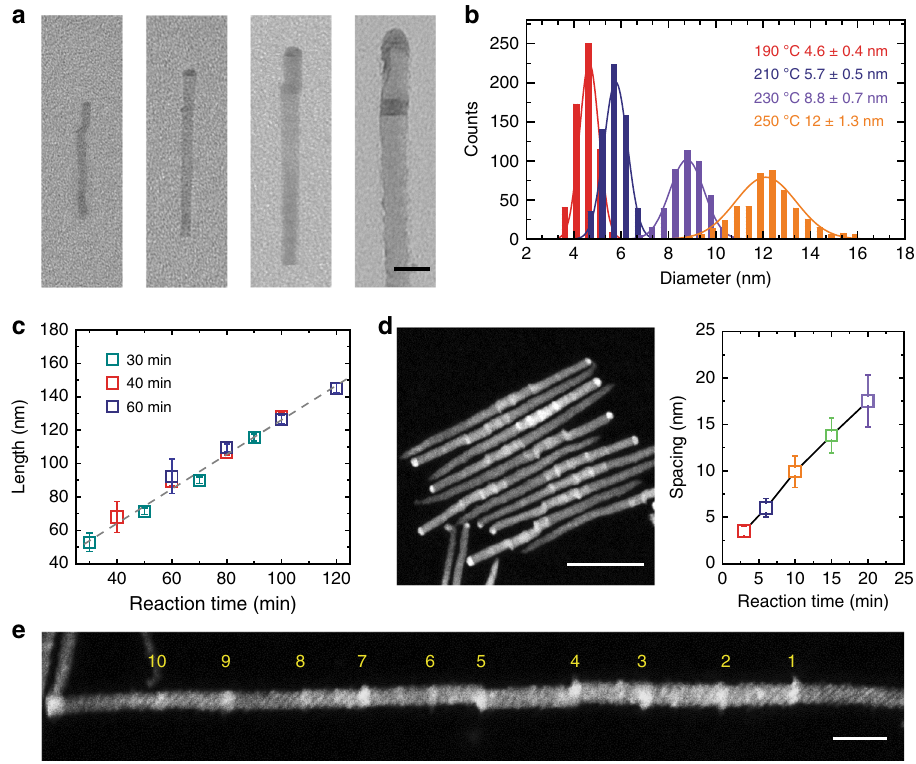
Fig. 3 Modulation of geometric parameters in QDNWs. a , b Representative TEM images ( a , from left to right) and the corresponding diameter distributions ( b ) of CdS – ZnS QDNWs grown at temperature of 190 °C, 210 °C, 230 °C, and 250°C, respectively. c Time dependence of nanowire length for QDNWs with different initial ZnS growth time. Error bars in c correspond to standard deviation values of each newly grown ZnS segment. d (Left panel) Dark- fi eld STEM image of QDNWs with modulated spacings of CdS QDs. (Right panel) The spacing of two adjacent CdS QDs (i.e., ZnS length) versus ZnS growth time. Error bars in d correspond to standard deviation values of each newly grown ZnS segment. e Representative STEM image of an ultralong QDNW with 10 CdS QDs (i.e., 21 segments in total). Scale bars are 20 nm, 50 nm, and 20 nm for a , d , and e ,